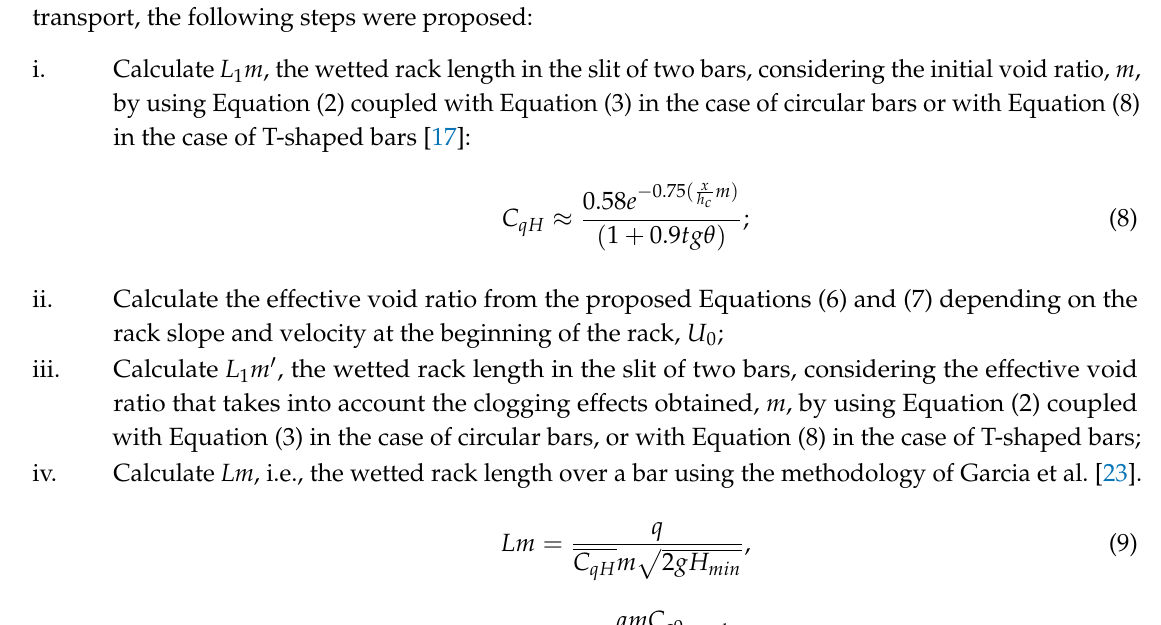
0 , d 50 c /b 1 , and W